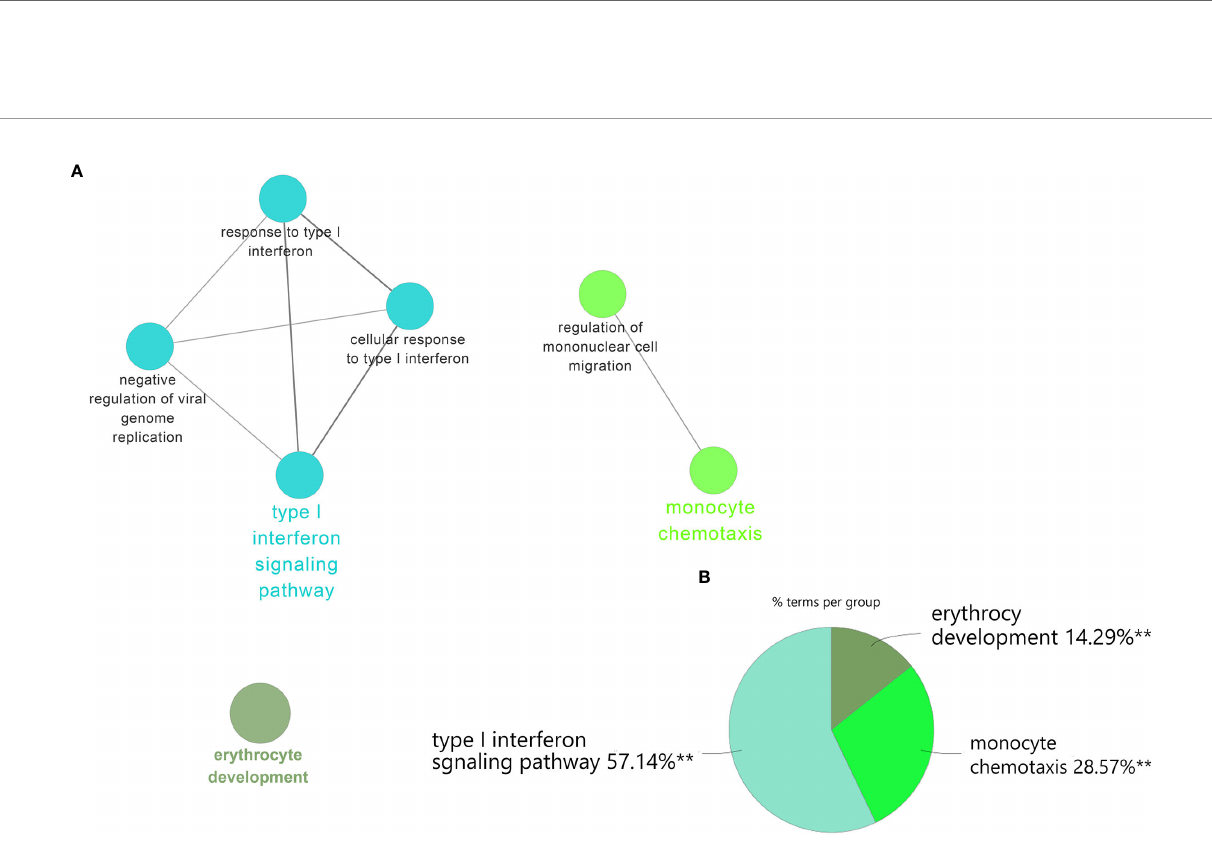
FIGURE 5 | Identi fi cation of the common DEGs. (A) The Venn diagram of the upregulated genes in GSE81622 and GSE703. (B) The Venn diagram of the downregulated genes in GSE81622 and GSE703. DEGs differentially expressed genes.